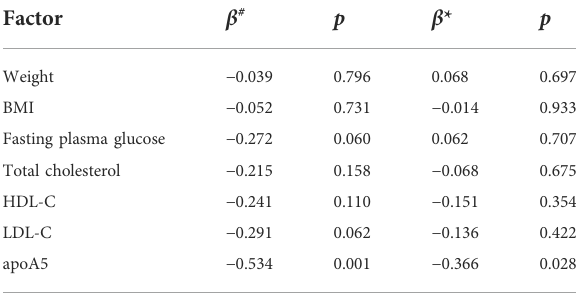
TABLE 3 Stepwise multiple regression analysis detecting independent contributors to plasma triglyceride levels in schizophrenia